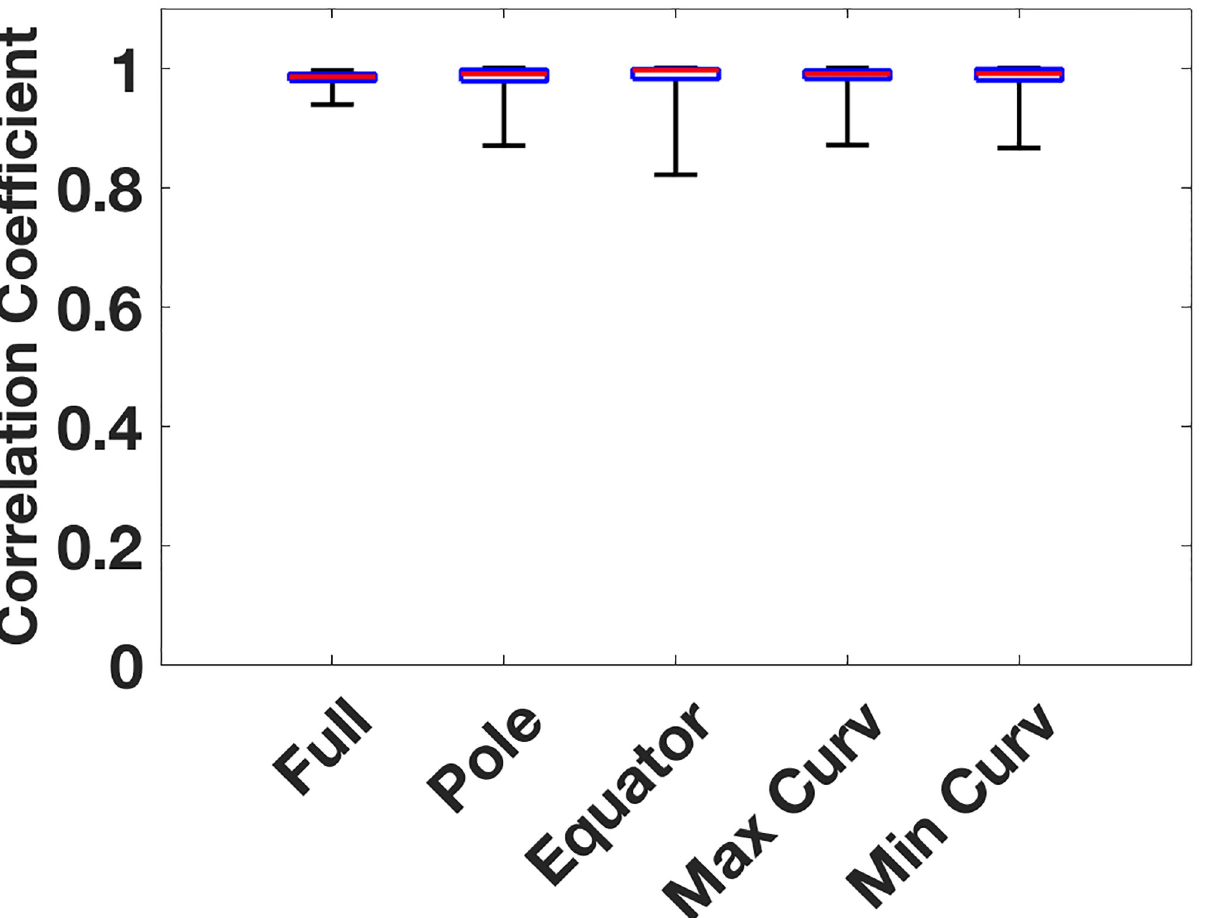
Fig 5. Correlation coefficient of 2D and 3D tip density does not depend on tip location or shell curvature. Plotted are, for all patients, the correlation coefficient between the 2D and 3D tip density maps for all electrodes (Full), electrodes located at the poles of the basket (Pole), the equator (Equator), and for the 7 electrodes with maximal (Max Curv) and minimal (Min Curv) mean curvature. The red bar represents the median value for each data set.